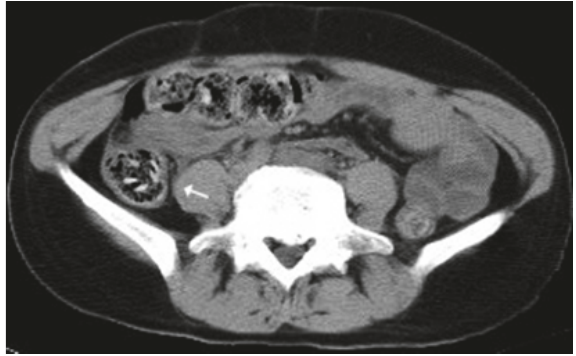
Figure 1: CT imaging; intraluminal phytobezoar appearance with persimmon seeds (arrow).